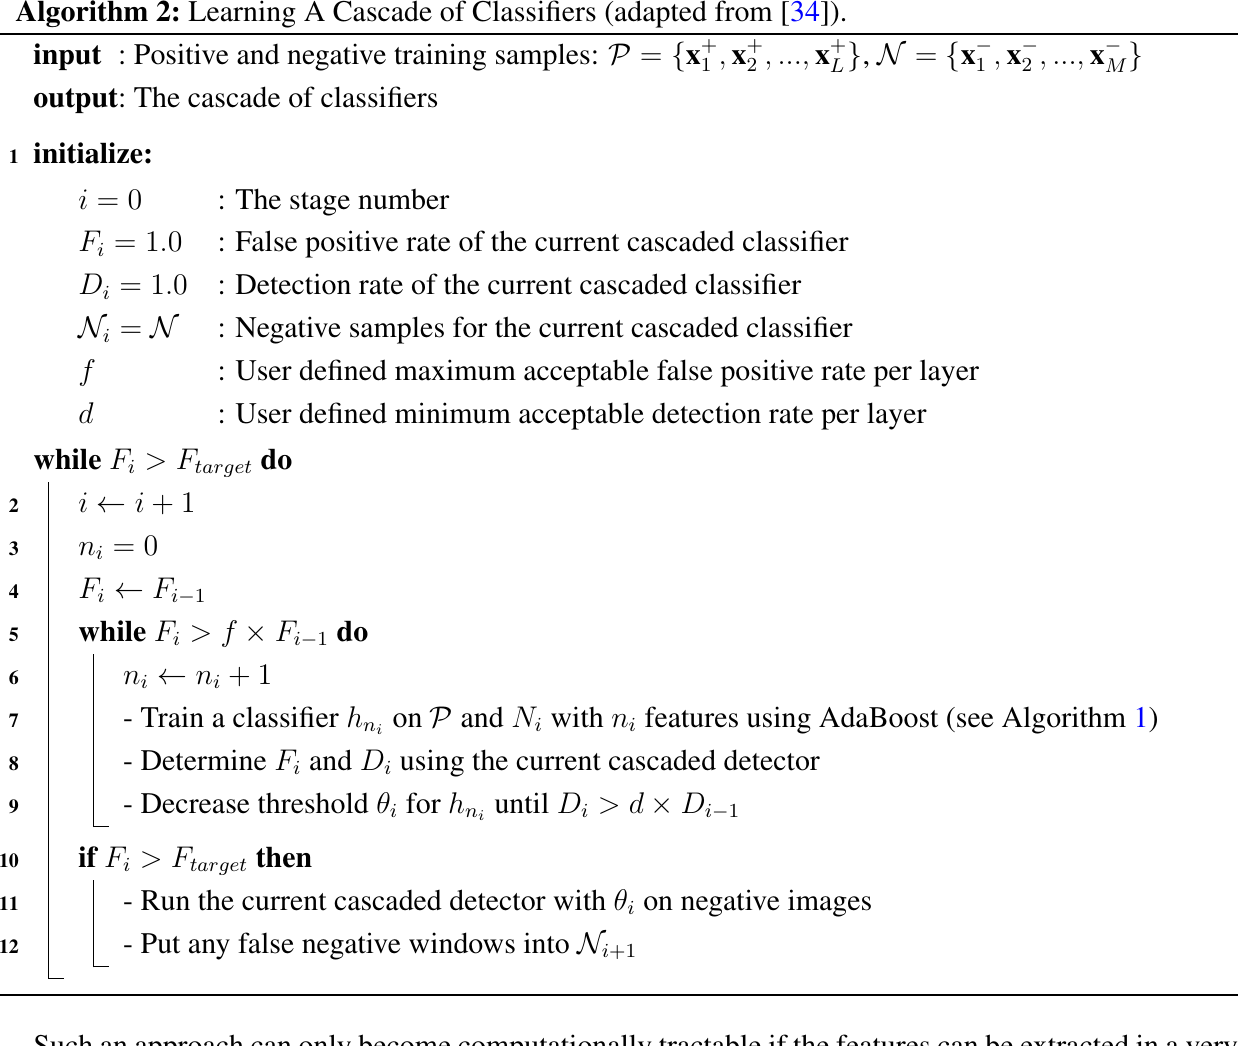
Algorithm 2: Learning A Cascade of Classifiers (adapted from